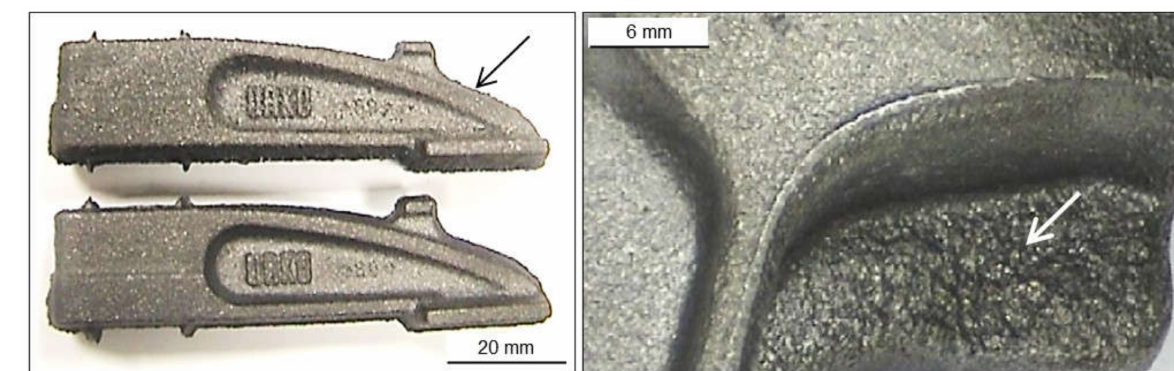
Figure 14. Examples of poor surface finish in iron